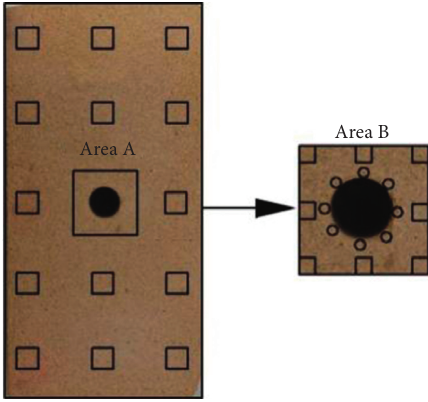
Figure 1: Single-hole yellow sandstone observation